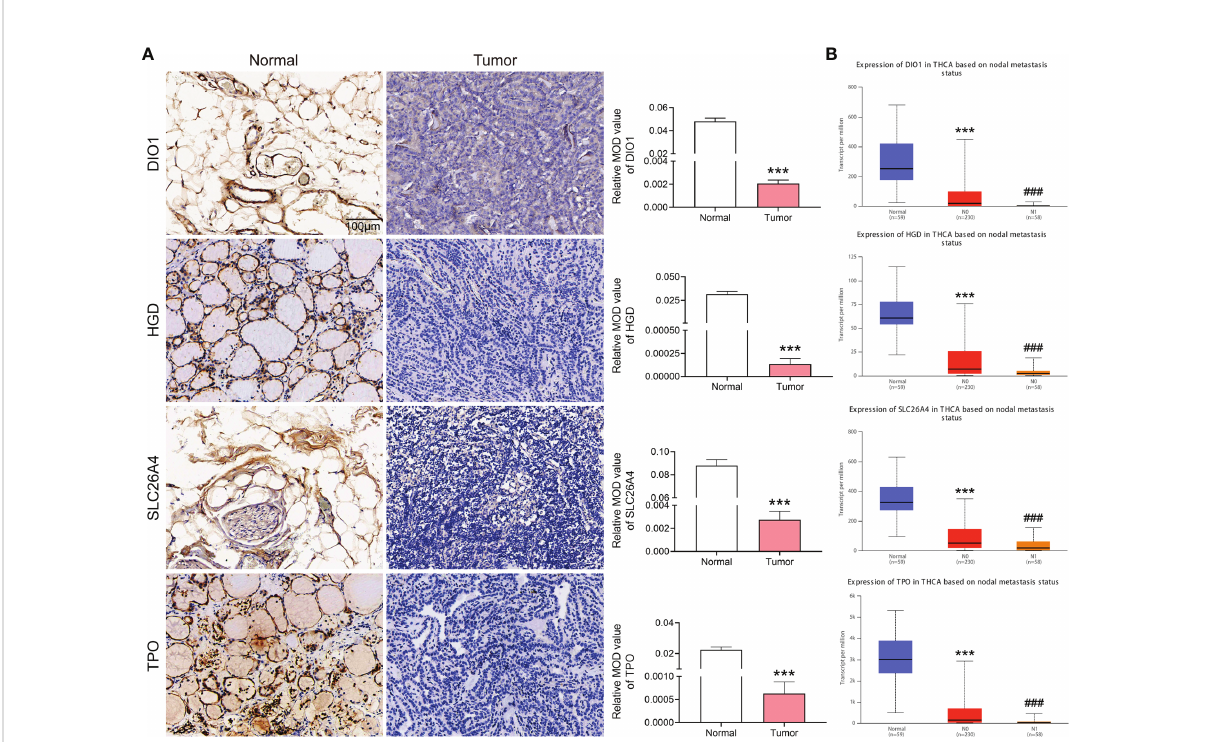
FIGURE 6 Expression of DIO1 , HGD , SLC26A4 , and TPO in metastatic papillary thyroid carcinoma (PTC) and adjacent normal tissues, and in different stages in the database. (A) Immunohistochemical staining of clinical samples, the expression of DIO1, HGD, SLC26A4 and TPO in normal and metastatic PTC. (B) DIO1 , HGD , SLC26A4 , and TPO expression in normal, PTC, and metastasized PTC based on TCGA database. N0: No regional Lymph node metastasis. N1: Metastases in 1 – 3 axillary Lymph nodes. ***P < 0.001 vs. normal group; ### P < 0.001 vs. N0